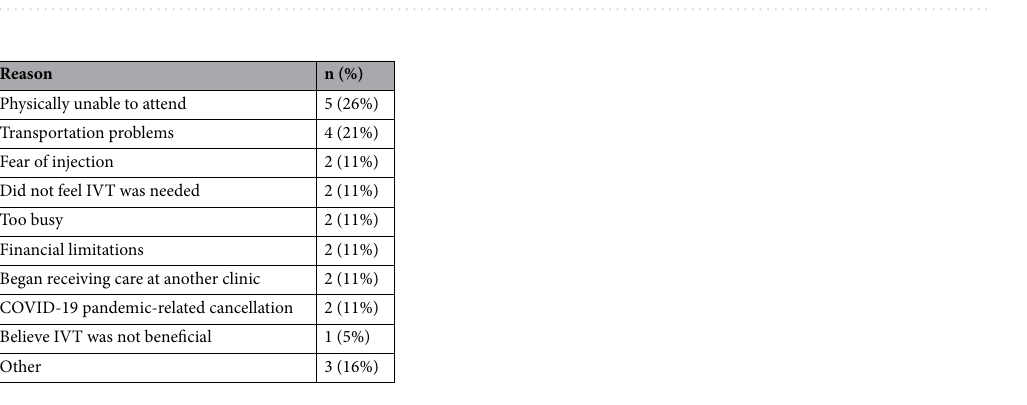
Figure 3. Responses from survey questions exploring potential factors that may influence patient non- compliance, expressed as a 100% stacked column chart of Likert-scaled results. n = 53–54 responses as in Table 2.